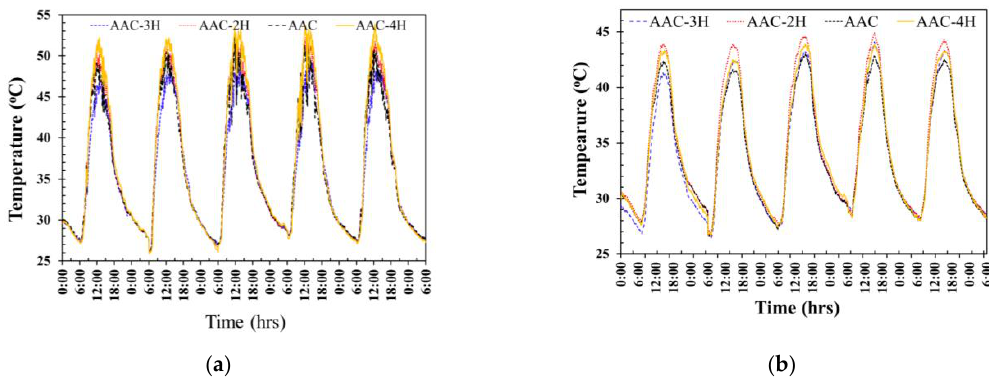
Figure 11. ( a ) exterior and ( b ) interior wall surface temperature of the 4 testing rooms in real weather.